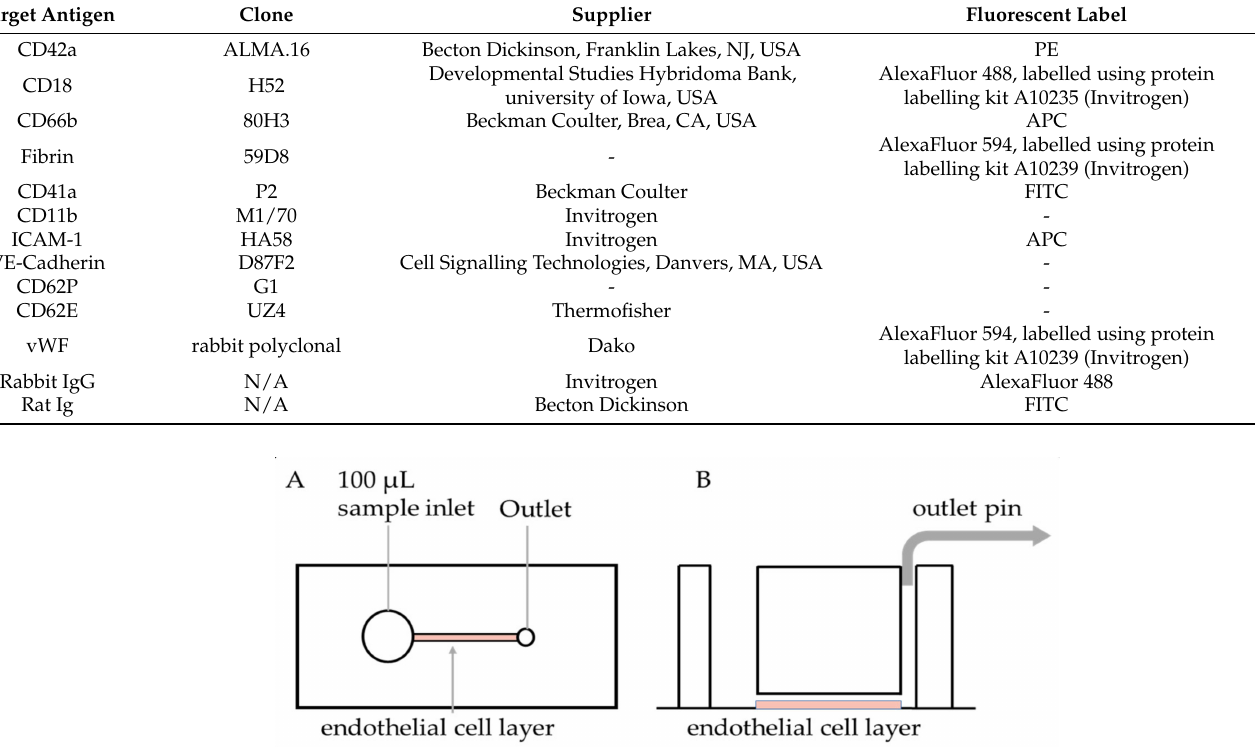
Figure 1. Design of endothelialised microfluidic chip. ( A ) Top and ( B ) side views of the Poly- dimethylsiloxane (PDMS) chip. Each chip consists of an inlet well, straight channel and an outlet pin connected to the pump which perfuses the inlet fluid at pre-determined shear rates. An endothelial cell suspension is added to the well, perfused over the channel and allowed to create a monolayer on the